Question: Generate an informative caption for the figure above.
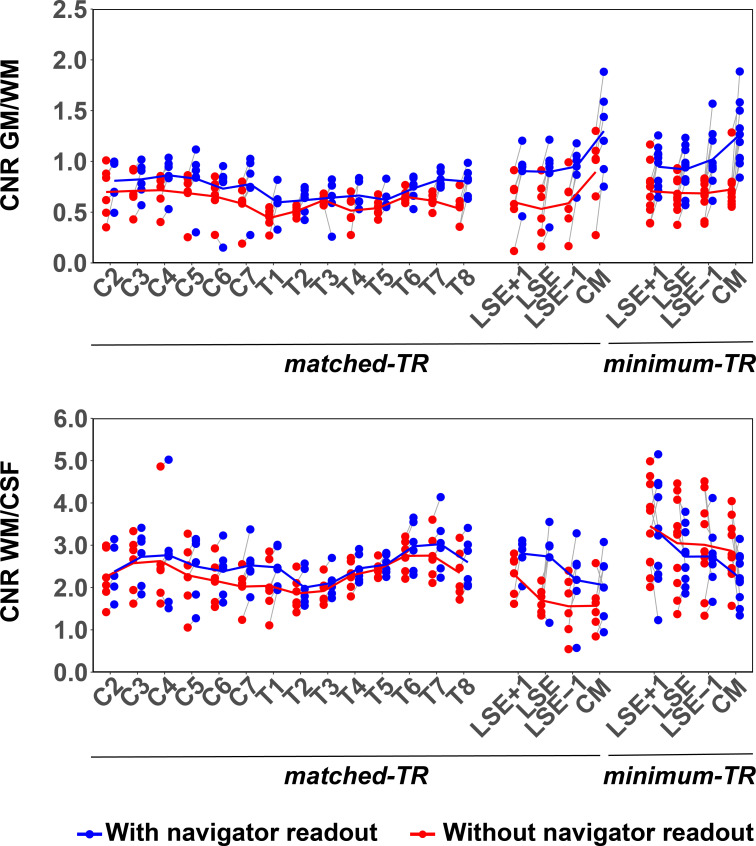
Answer: CNR across the spinal cord with and without navigators. Contrast-to-noise ratio (CNR) between gray matter (GM) and white matter (WM), and between WM and cerebrospinal fluid (CSF), measured on multi-echo gradient-echo acquisitions with navigators and optimized navigator processing using a fast Fourier transform-based approach (blue), and on acquisitions without navigators (red). Dots represent individual participants’ values, with values from the same participant connected by a gray line. The two acquisition types were obtained either with matched repetition times ( matched-TR, n = 6) or with the minimum achievable repetition time ( minimum-TR, n = 10). Averaged values across participants are shown as a solid line across cervical (C2–C7) and thoracic (T1–T8) vertebral levels, as well as across lumbosacral anatomical landmarks, including the lumbosacral enlargement (LSE), two slices rostral (LSE+1), two slices caudal (LSE-1), and the conus medullaris (CM).